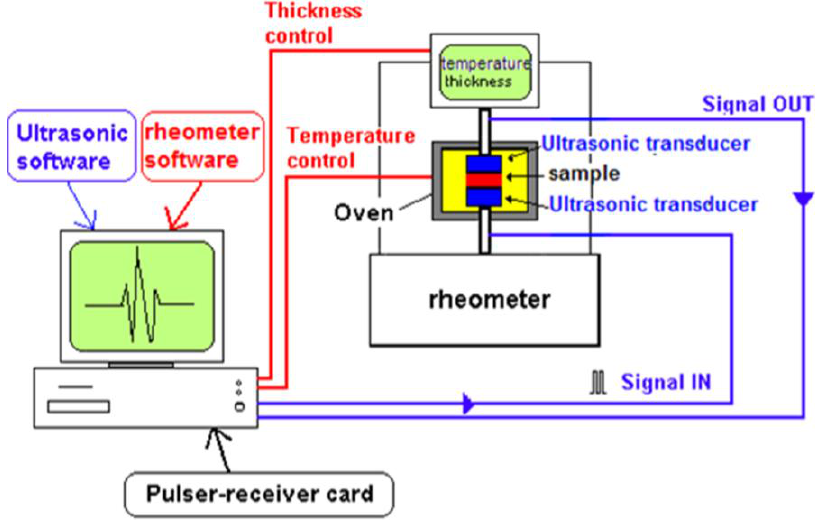
Figure 1. Schematic drawing of the ultrasonic set-up for cure monitoring (adapted from